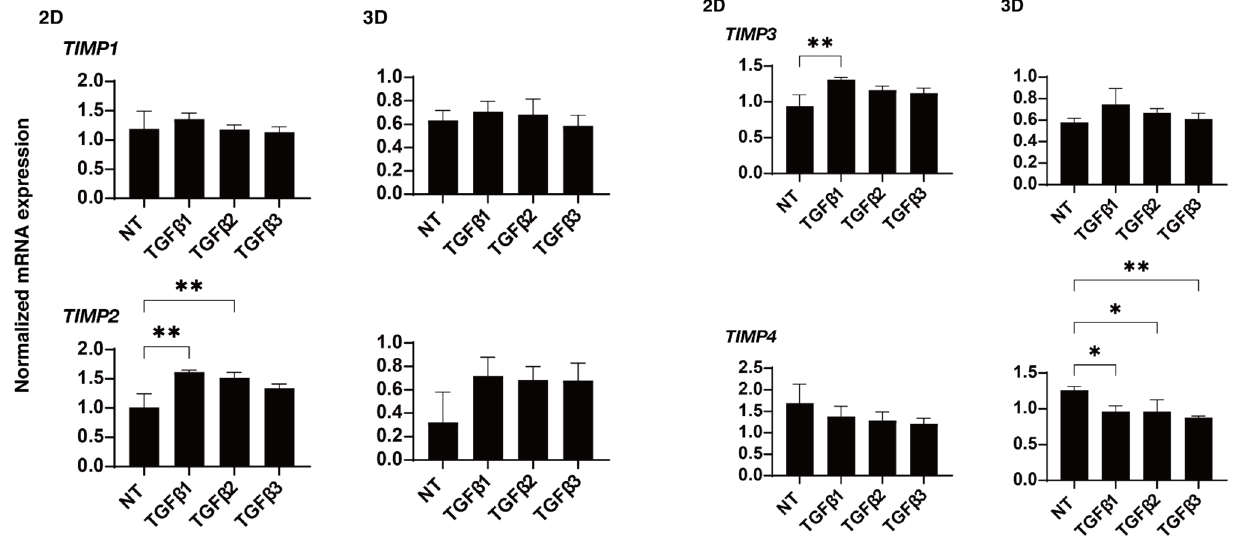
Figure 5. Effects of TGF ‐β isoforms on immunolabeling against ECM molecules in 2D ‐ and 3D ‐ cul ‐ tured HTM cells. At day 6, 2D ‐ and 3D ‐ cultured HTM cells (NT, non ‐ treated control) and cultures treated with 10 ng/mL TGF ‐β‐ 1, 5 ng/mL TGF ‐β‐ 2, or 1 ng/mL TGF ‐β‐ 3 were subjected to immunoflu ‐ orescent labeling of ECMs ( COL1 , COL4 , COL6 , FN, and aSMA ). All experiments were performed in duplicate using fresh preparations (n = 5, total 10). Representative merged images with DAPI (blue) and ECM (green) are shown (panel ( A ) left ; 2D, panel ( B ) left ; 3D, scale bar; 100 μ m). The im ‐ munostaining levels of each target molecule among the observed areas were evaluated using Image J (NIS ‐ Elements 4.0 software) and plotted (panel ( A ) right ; 2D, panel ( B ) right ; 3D)